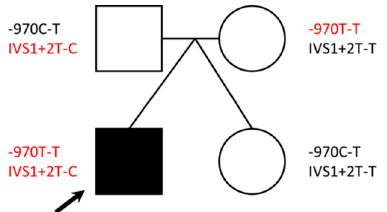
Figure 3. DBH variants identified. The pedigree shows genotypes for two DBH variants identified for each family member. Variants in red have been shown in the literature to have reduced DBH activity. Note: black arrow = proband.